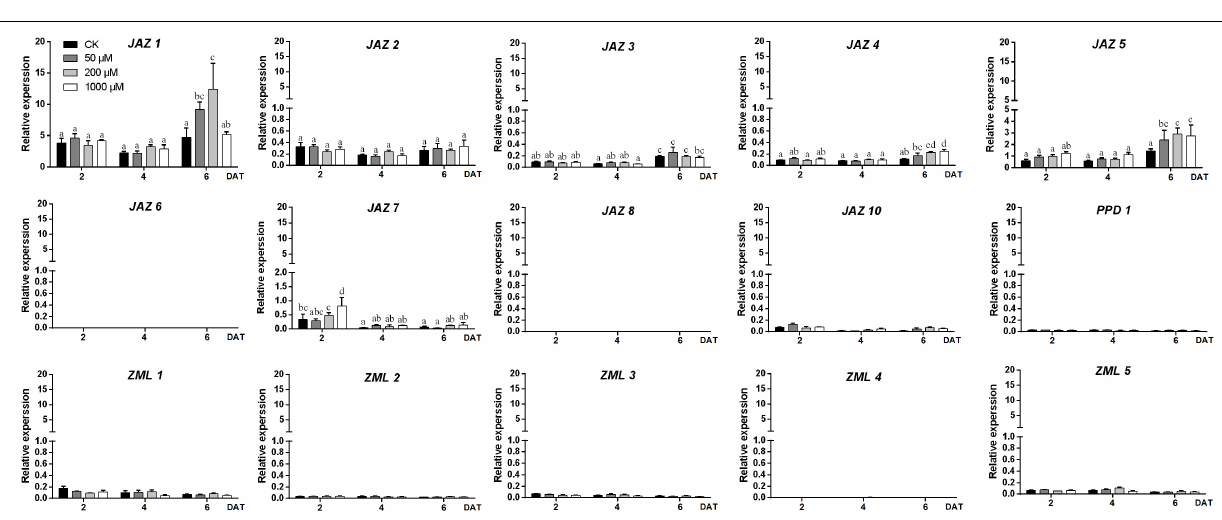
“PpJAZ10BD × PpJAZ1AD,” “PpJAZ7BD ×